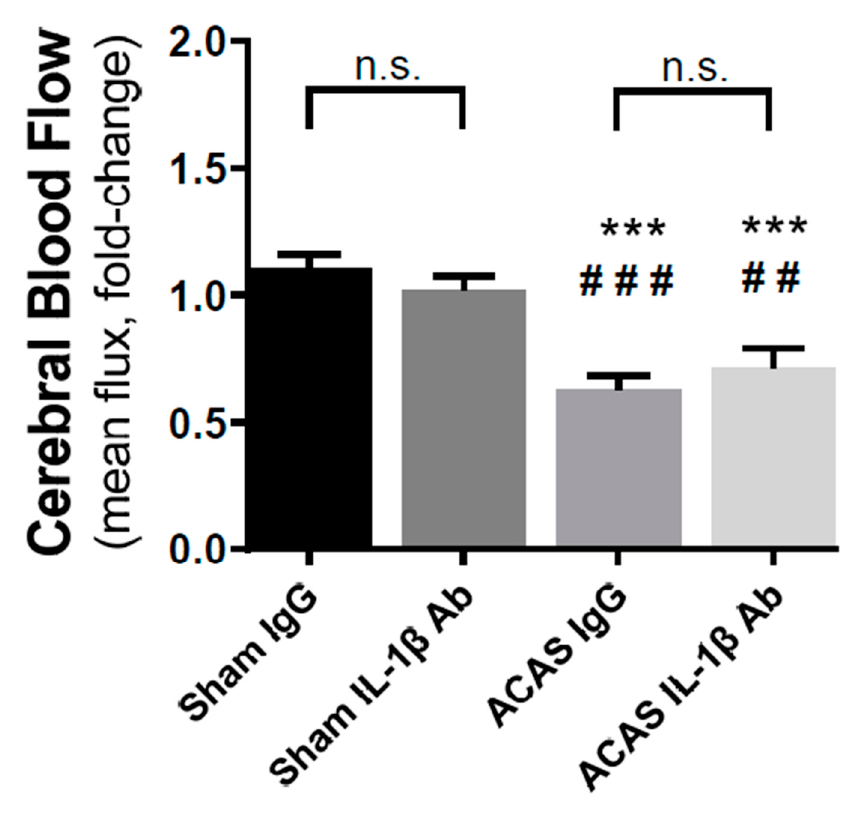
Figure 2. Effects of ameroid constrictor, arterial stenosis (ACAS) surgery and IL-1 β on cerebral blood flow 36 days after ACAS or sham surgery and the initiation of IL-1 β antibody or IgG treatment. N = 9 mice/group; *** p < 0.001 vs. sham IgG; ### p < 0.001 vs. sham IL-1 β Ab. n.s. = not significantly different.